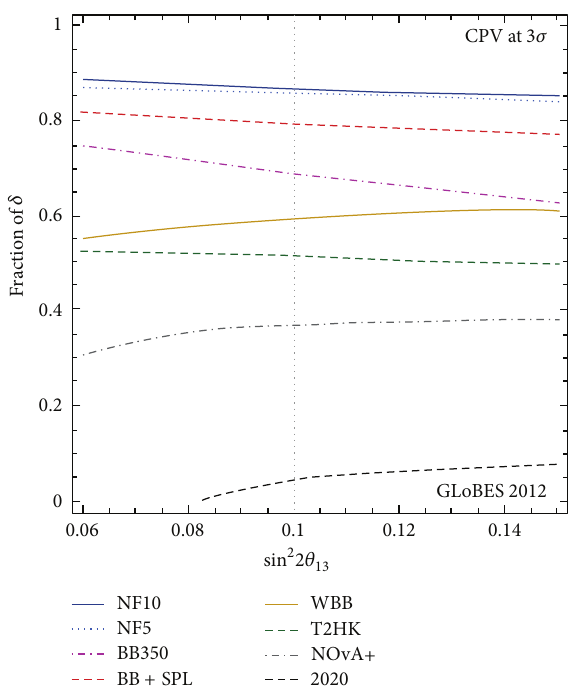
Figure 19: 𝛿 -fraction for 3𝜎 CP violation sensitivity for an upgrade of NOvA with a 30 kton LAr detector (NOvA+), T2HK, a WBB with a baseline of 2300 km and a 100kton LAr detector (WBB), a low energy betabeam combined with the SPL superbeam and aimed at WC detector at 130km, a higher energy betabeam (BB350), a neutrino factory with 10GeV (NF10) and 5 GeV (NF5) muons and a 100kton MIND detector, as well as the expected reach by 2020 by combining NOvA, T2K, and reactor data. Figure is taken from